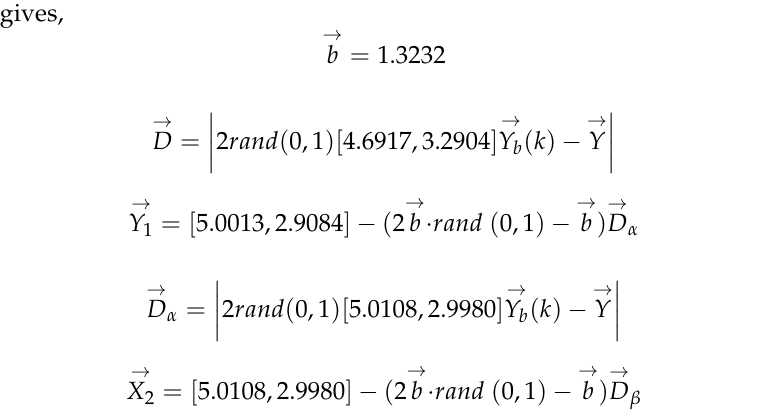
Table 3. Objective function values for random values of Y1 and Y2.